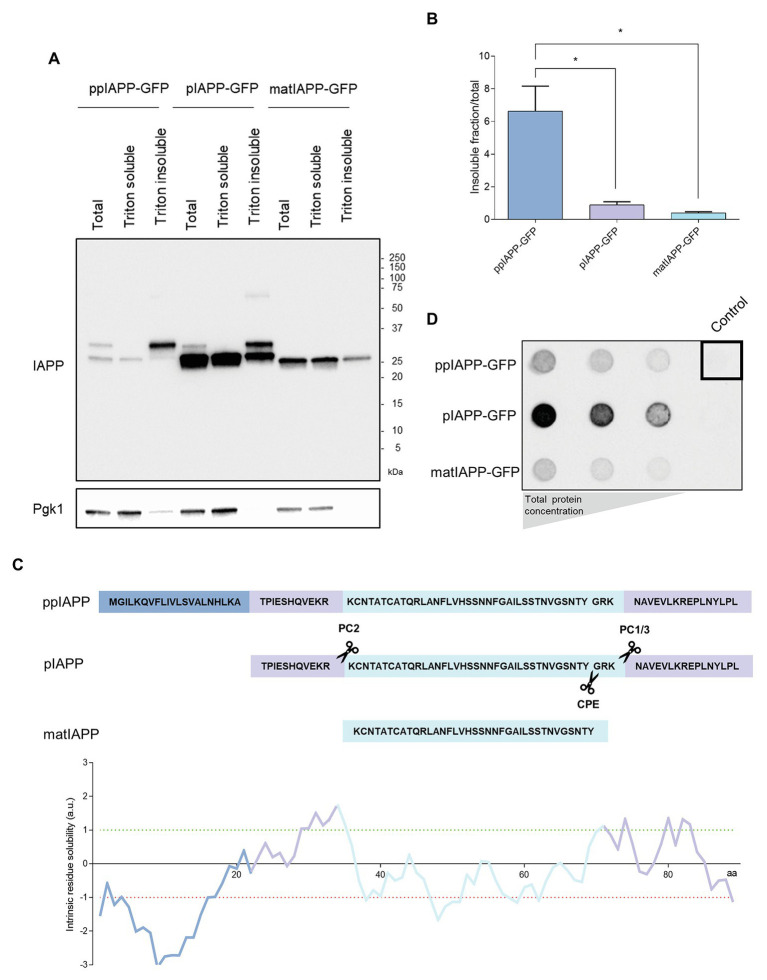
Immature IAPP entities are restricted to Triton insoluble fractions and are differentially retained in filter-trap assays. (A) The protein extracts were separated according to their solubility and assessed by immunoblotting using anti-IAPP antibody. Pgk1 was used as loading control. (B) The ratio between the insoluble fraction and total protein was calculated for each strain. (C) Schematic representation of IAPP processing and solubility. The sequences of the signal peptide (SP; dark blue), the N-terminal and C-terminal flanking regions of the propeptide (medium blue), and the matIAPP (light blue) as well as the processing sites of the prohormone convertases PC2 and PC1/3 are shown. The intrinsic solubility of each amino acid of the full length ppIAPP was predicted computationally (lower panel). (D) Filter-trap assays of total protein lysates obtained from ppIAPP-GFP, pIAPP-GFP, and matIAPP-GFP cells induced with galactose for 12 h, and probed with anti-IAPP antibody. Protein concentration loaded in the membranes: 50, 10, and 5 μg (from left panel to right panel). Representative images are shown, and the values represent mean ± SD from at least three independent experiments. Statistical differences are denoted as *p < 0.05.